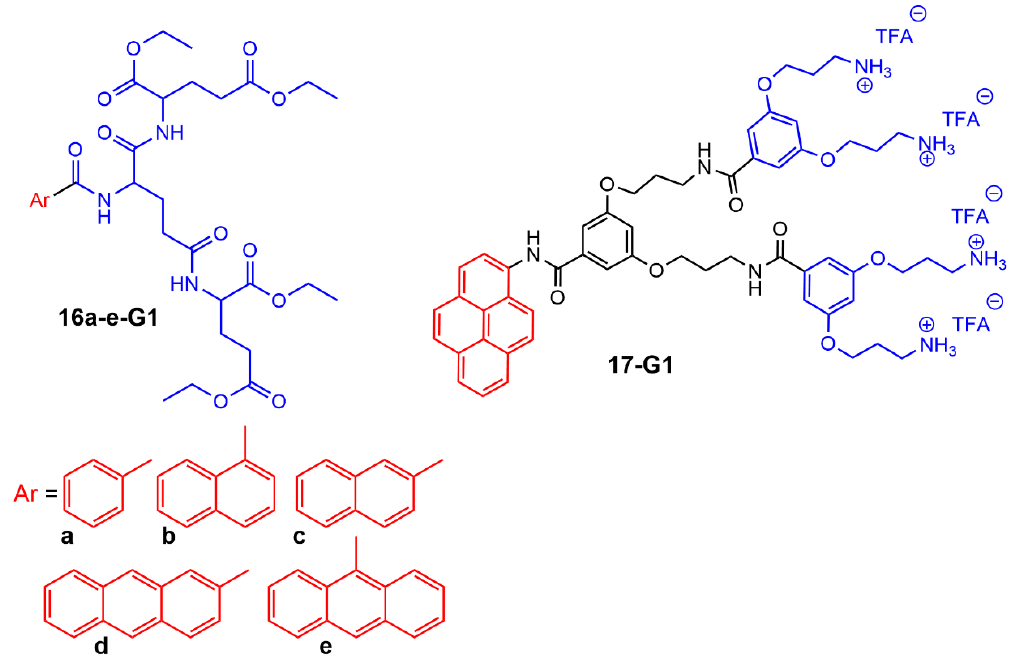
Figure 13. Examples of amphiphilic dendrons, for which the dendritic part is hydrophilic and the core is a lipophilic aromatic group. core is a lipophilic aromatic group.